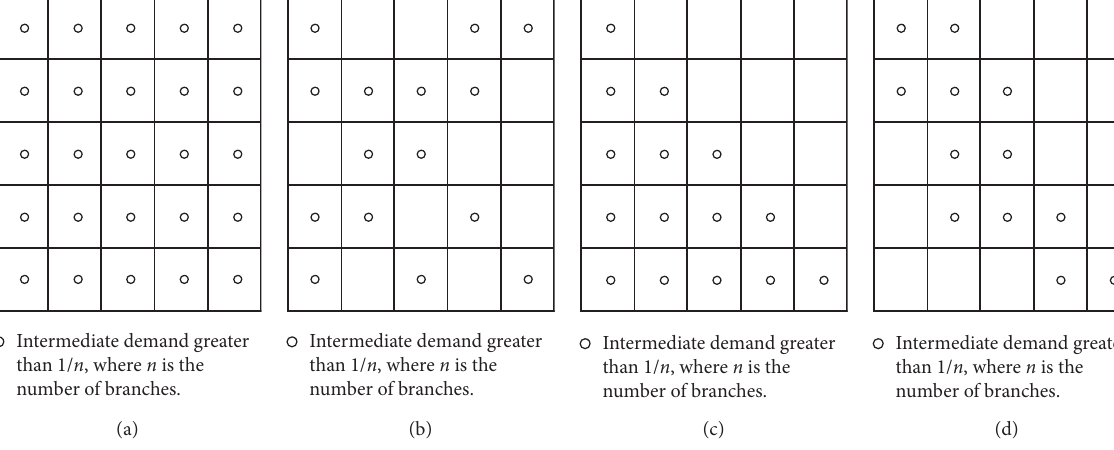
Figure 1: Basic concepts of structural analysis: (a) interdependence; (b) independence; (c) hierarchy; (d)